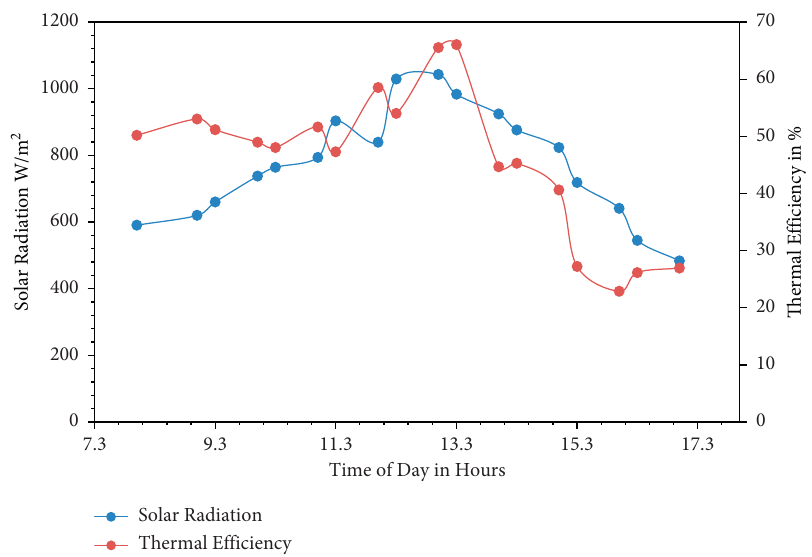
Figure 6: Termal efciency of the SAH with inverted bafe plate.